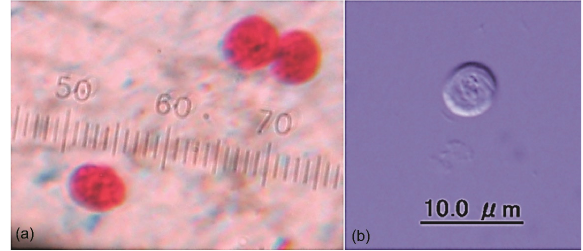
Figure 1. Cryptosporidium parvum Oocyte Size (4.5 × 4.2 µm) by the Modified Acid‐fast Staining Method and (b) Cryptosporidium hominis ( 6.5 × 4.7). Note . The size of oocysts varies in different species of